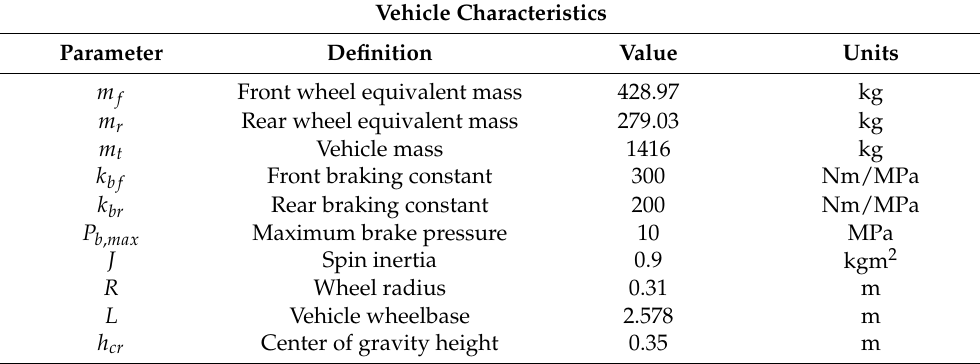
Table 3. Vehicle